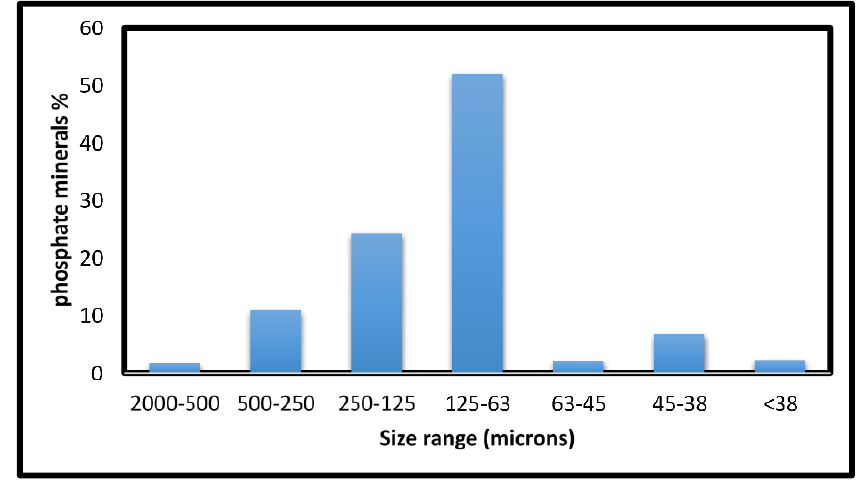
Figure 1. Distribution of phosphate minerals in different size fractions of the tailing samples as determined by XRD.